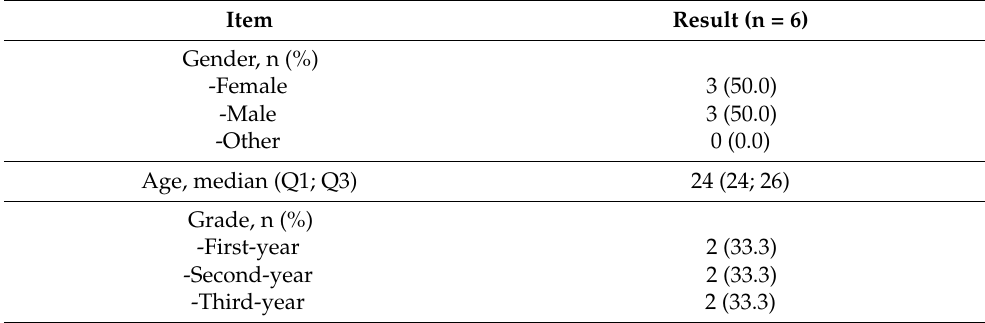
Table 4. Characteristics of students who took part in the interviews